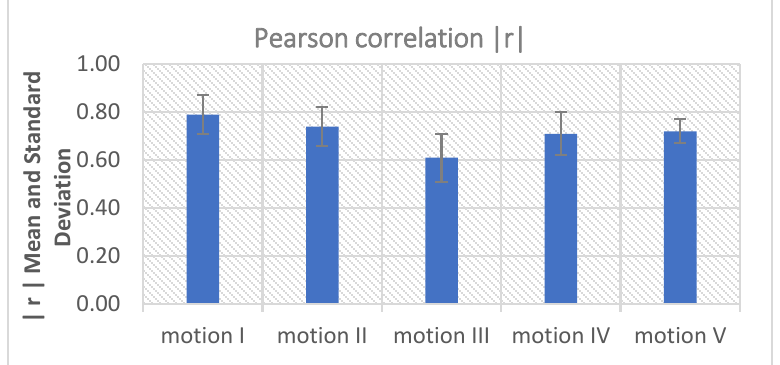
Figure 9. The correlation between low-pass filtered ECG and IP signal.